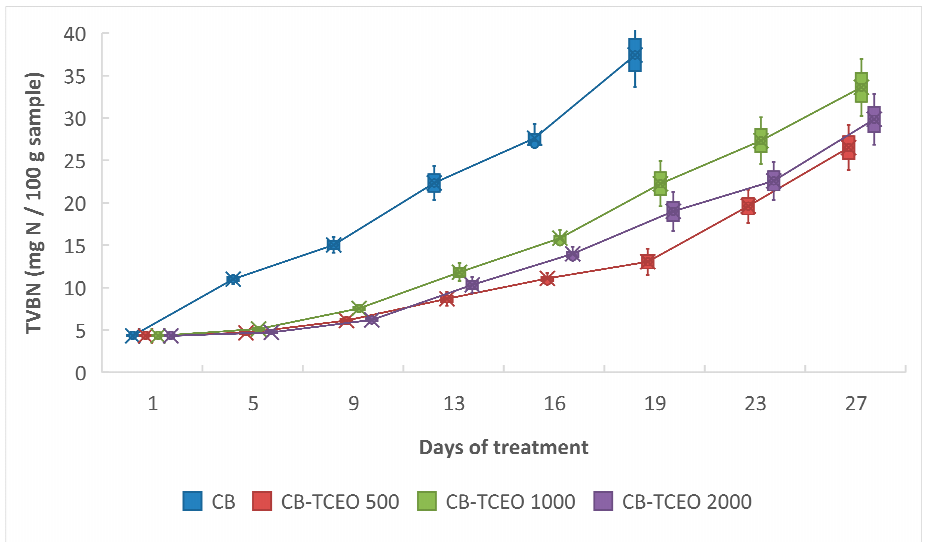
Figure 5. Effect of the CB-TCEO on total volatile basic nitrogen (TVB-N) of Oreochromis mossambicus fillet during storage at 4 °C.